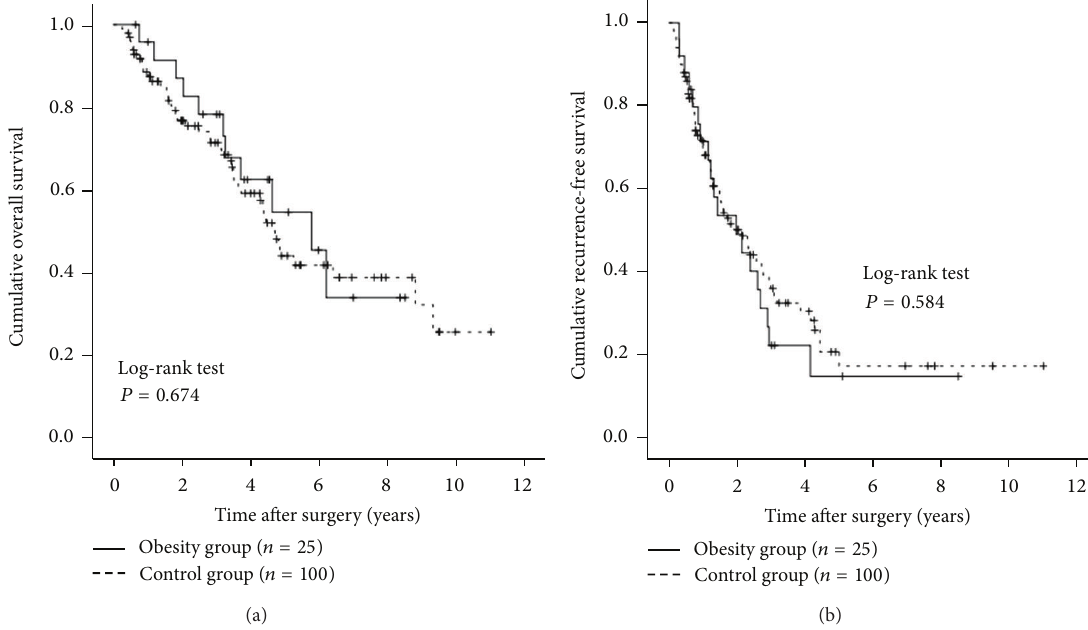
Figure 4: Subgroup analyses in patients aged 70 years or more ( 𝑛 = 125 ). There were 25 patients aged 70 years or more in the obesity group and 100 in the obesity group. There were no significant differences between the two groups in terms of OS (a) ( 𝑃 = 0.674 ) and RFS (b) ( 𝑃 = 0.584 ).